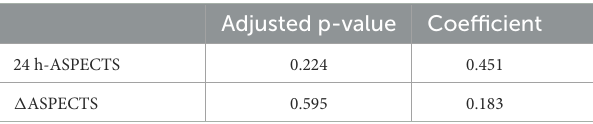
TABLE 5 Association between intravenous therapy and tissue